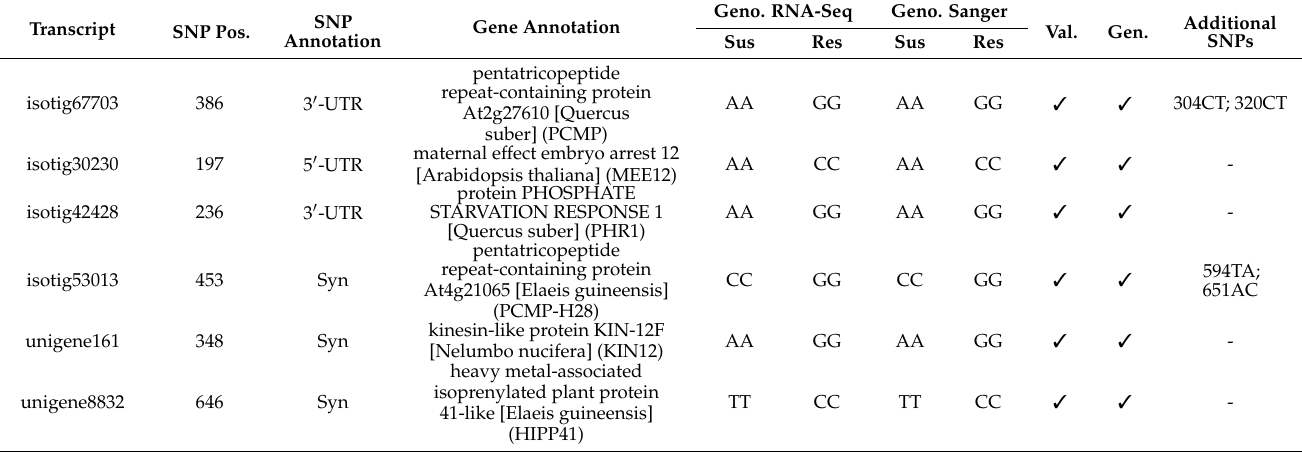
Table 2. Summary of the SNP validation.